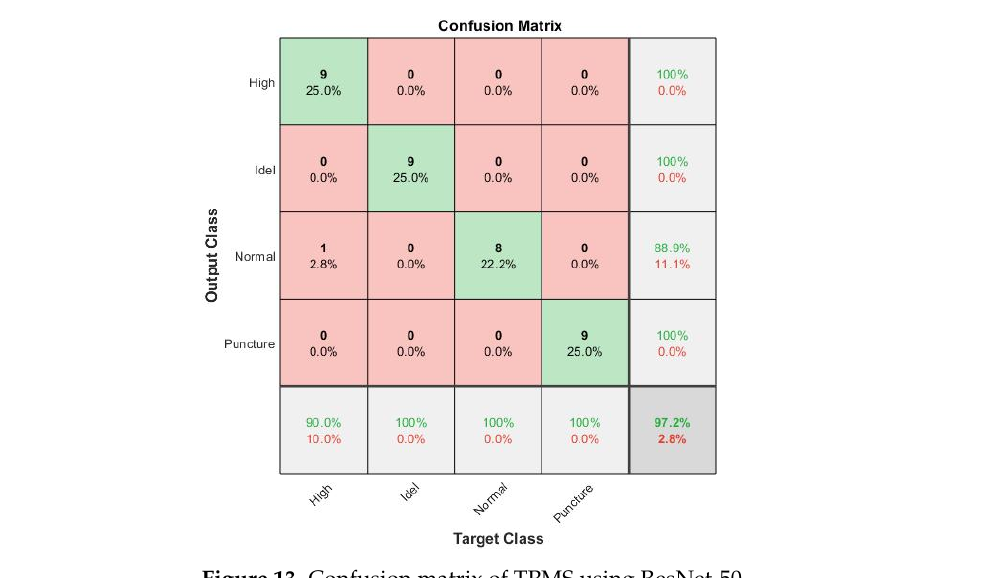
15 of 19 Figure 12. Performance evaluation of pretrained models using the best hyperparameters. Table 2. Best hyperparameters for the pretrained models. Pretrained Model